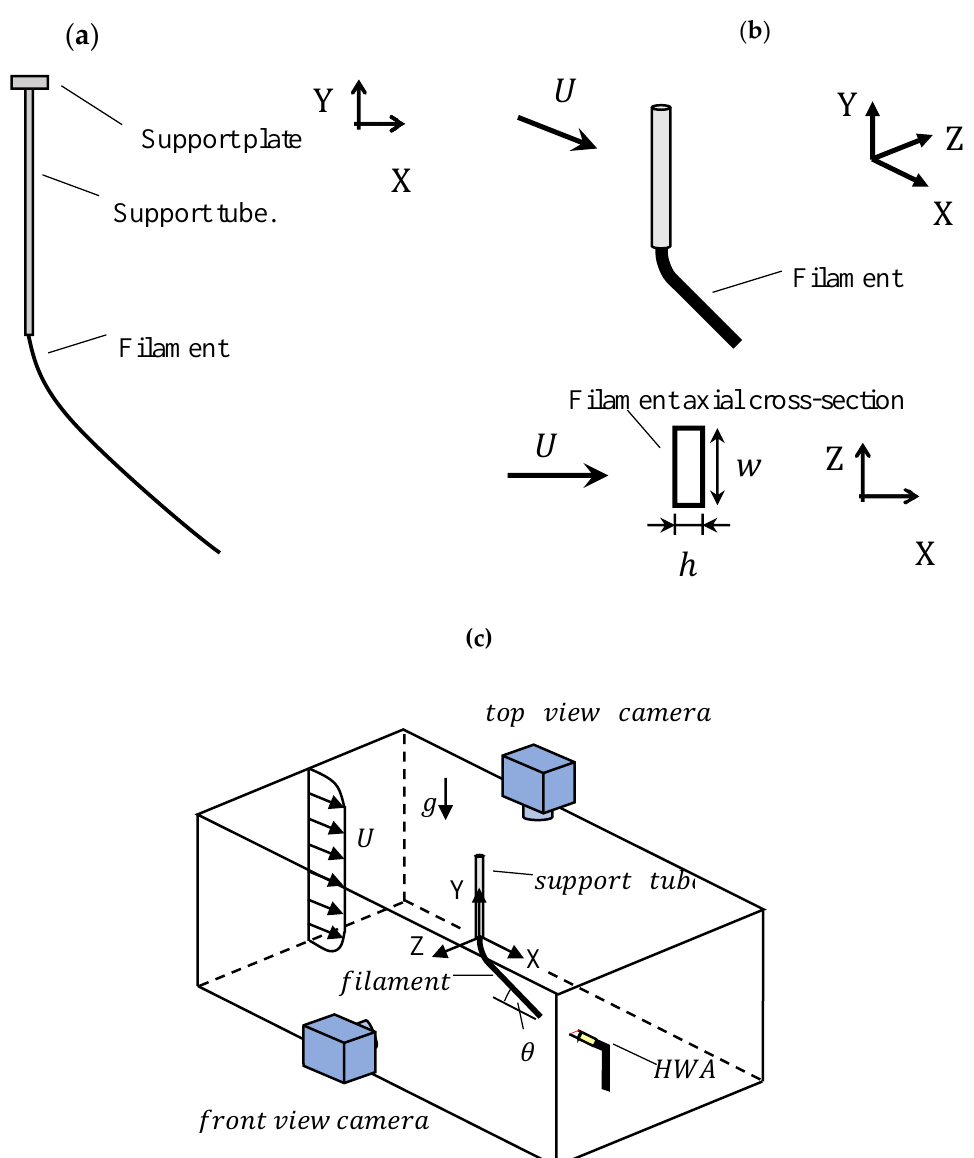
Figure 2. ( a ) Schematic representation of the test piece; ( b ) Filament orientation during the tests in the wind tunnel; ( c ) Schematic representation of the experimental wind tunnel setup.